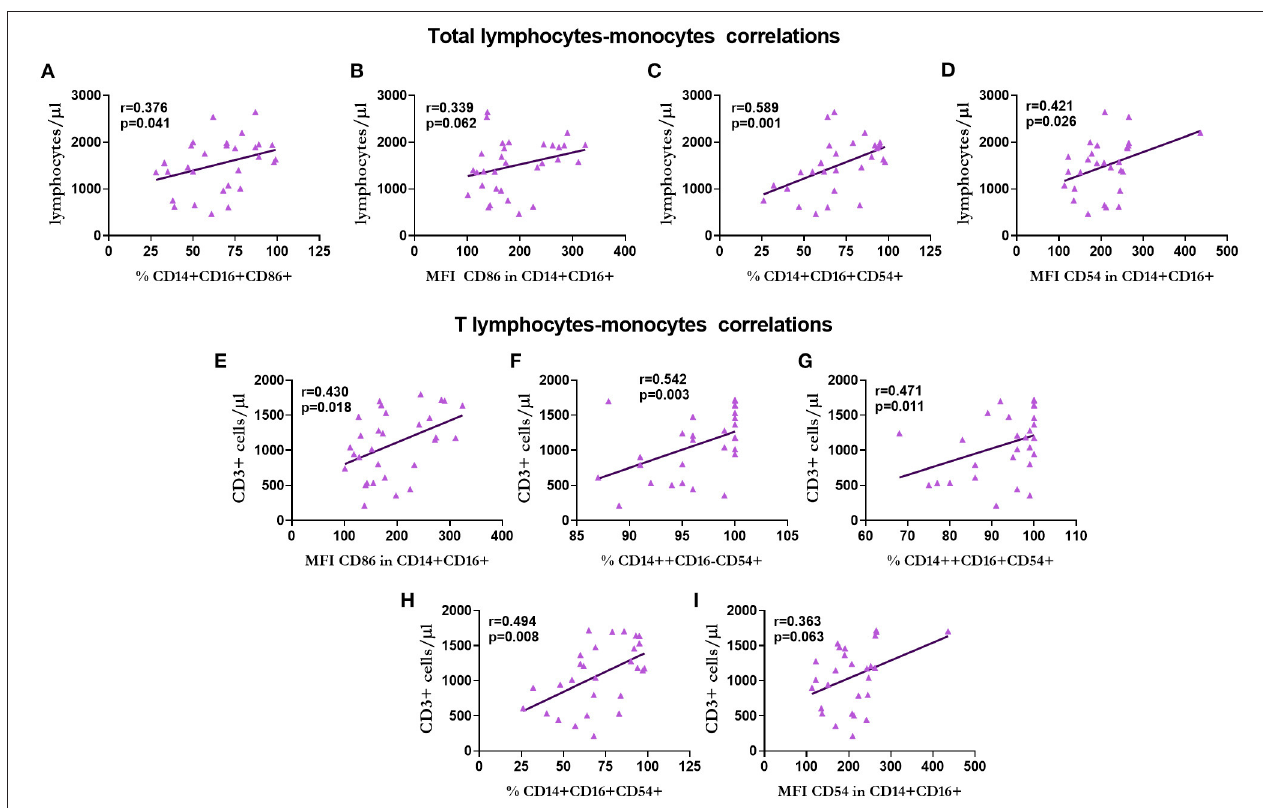
FIGURE 9 | Correlation between the number of total lymphocytes and T lymphocytes with monocytes in renal transplantation. Correlation of the total number of lymphocytes with the percentage of non-classical monocytes CD86 + (A) , expression of CD86 in non-classical monocytes (B) , percentage of non-classical monocytes expressing CD54 (C) , and expression of CD54 in non-classical monocytes (D) . Correlations of T lymphocytes with the expression of CD86 in non-classical monocytes (E) , percentage of classical (F) , intermediate (G) , and non-classical (H) CD54 + monocytes, and the expression of CD54 in non-classical monocytes (I) are